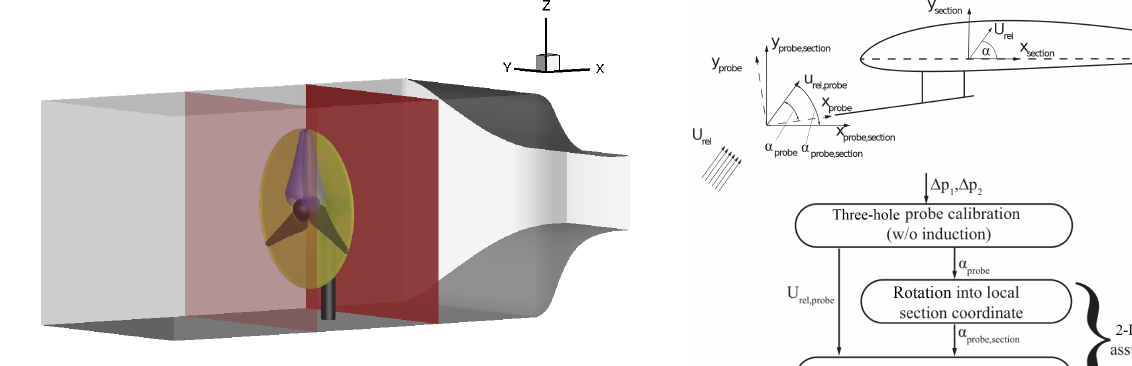
Figure 6. Position of the velocity planes for the RAV method (yel- low), surface for the determination of the AoA with the CircAve method (blue) and velocity planes (red).